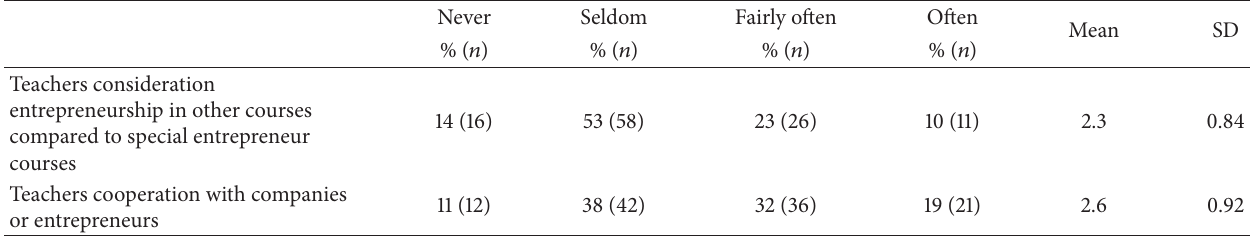
Table 2: The level of entrepreneurship consideration in teaching and the cooperation with entrepreneurs (teachers, 𝑛 = 111 ).